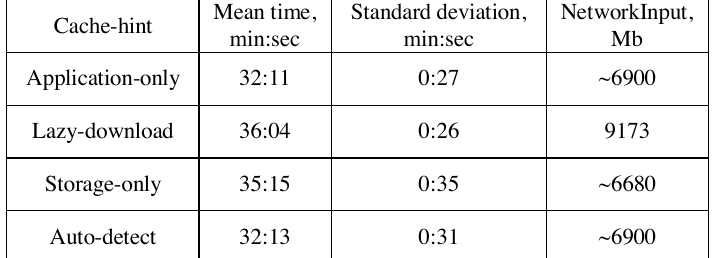
Table 1. Results from the cache-hint tests, averaged over ~10 tests per cache-hint.